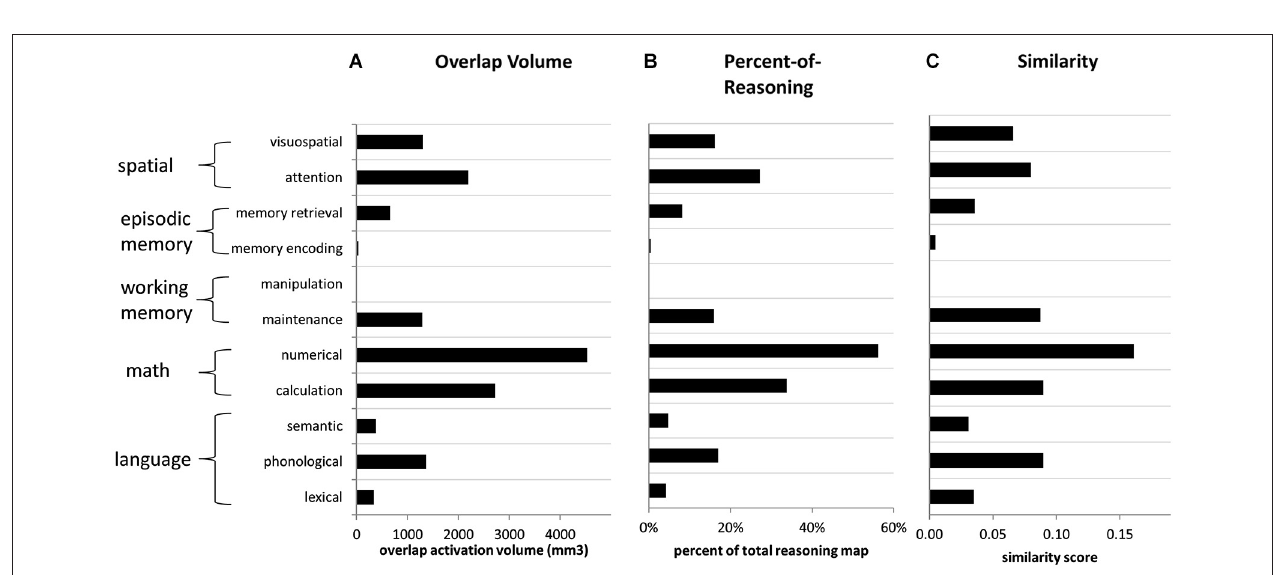
overlapped with each other feature, across all parietal ROIs. (C) Similarity scores comparing the reasoning map to the map associated with every other feature, across all parietal ROIs. Similarity was computed as the volume of overlap divided by the total volume of activation for both